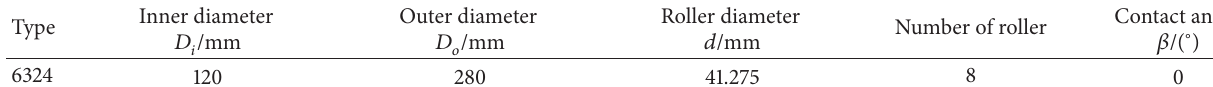
Table 1: Generator bearing parameters of wind turbine.